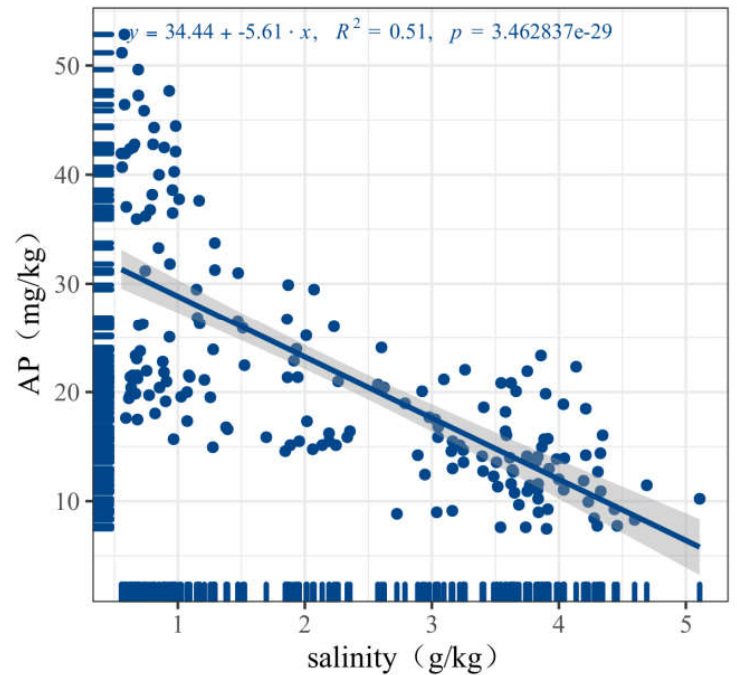
Figure 5. Scatter diagram between soil salt content and available